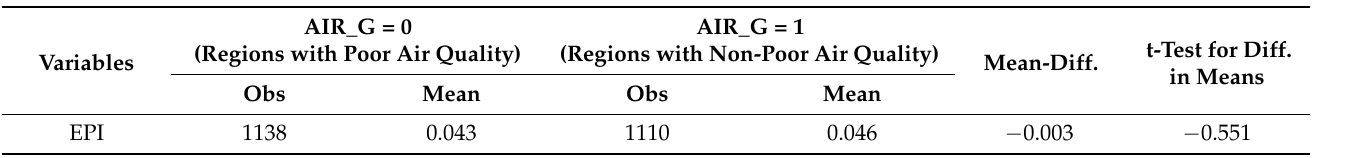
Table 12. Univariate